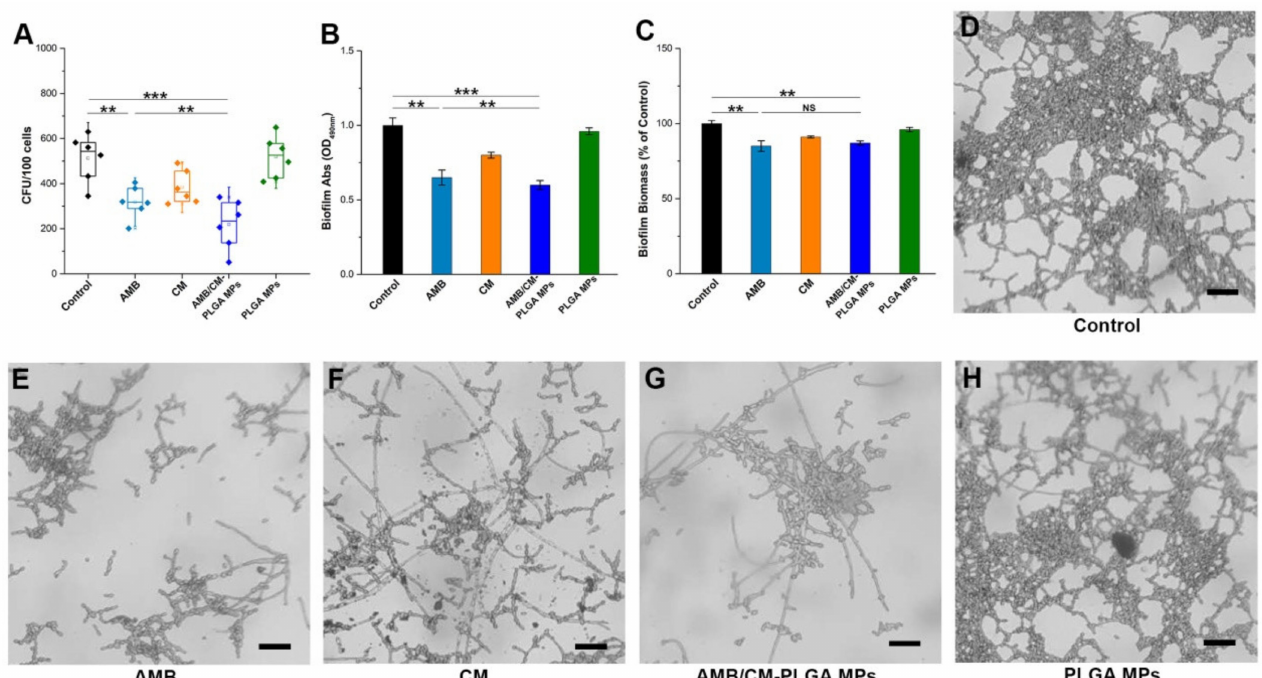
Figure 6. ( A ) Adhesion was inhibited significantly following treatment with AMB, CM, and AMB/CM-PLGA MPs, especially AMB/CM-PLGA MPs. ( B ) Activity of biofilm decreased signifi- cantly following treatment with AMB, CM, and AMB/CM-PLGA MPs, especially AMB/CM-PLGA MPs. ( C ) Biofilm biomass decreased significantly following treatment with AMB, CM, and AMB/CM- PLGA MPs, but there was almost no difference between AMB and the AMB/CM-PLGA MPs group. ( D – H ) Morphological observation of C. albicans at 24 h (bar = 20 µ m). The final concentration of AMB employed in the AMB group and the AMB/CM-PLGA MPs group was 0.5 µ g/mL. ** p < 0.05. *** p < 0.01. NS means no